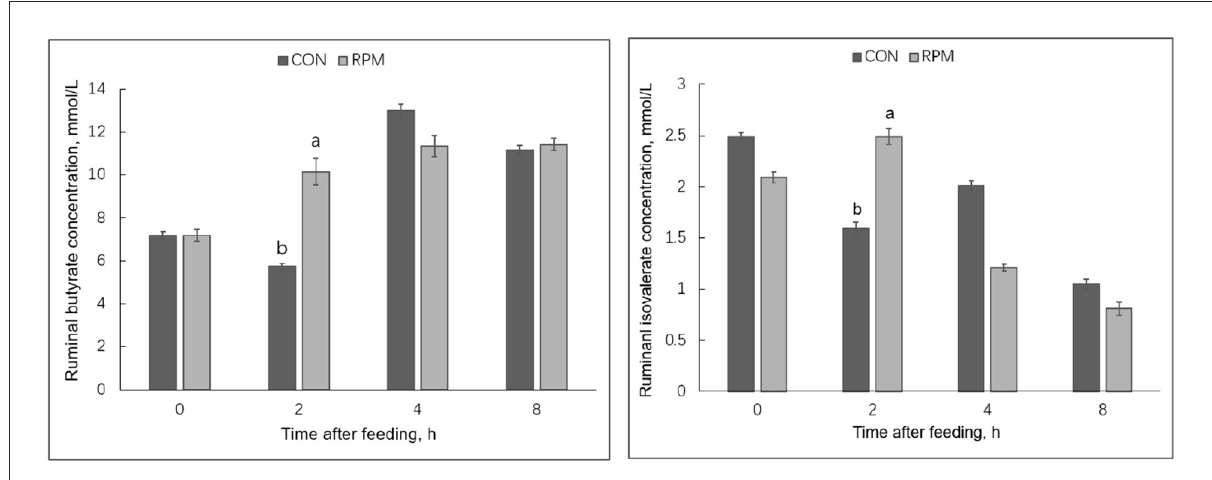
FIGURE1 Ruminal butyrate and isovalerate concentrations in Holstein cows fed a control diet 1 (CON) containing 17.3% CP or treatment diet containing 16.4% CP with RPM supplementation (RPM) at 0, 2, 4, and 8h after feeding. a,b Least squares means within a row with different superscripts differ ( p < 0.05). Bars indicate the standard error of the